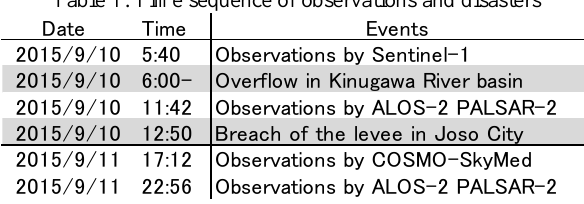
Figure 1. Target area Table 1. Time sequence of observations and disasters